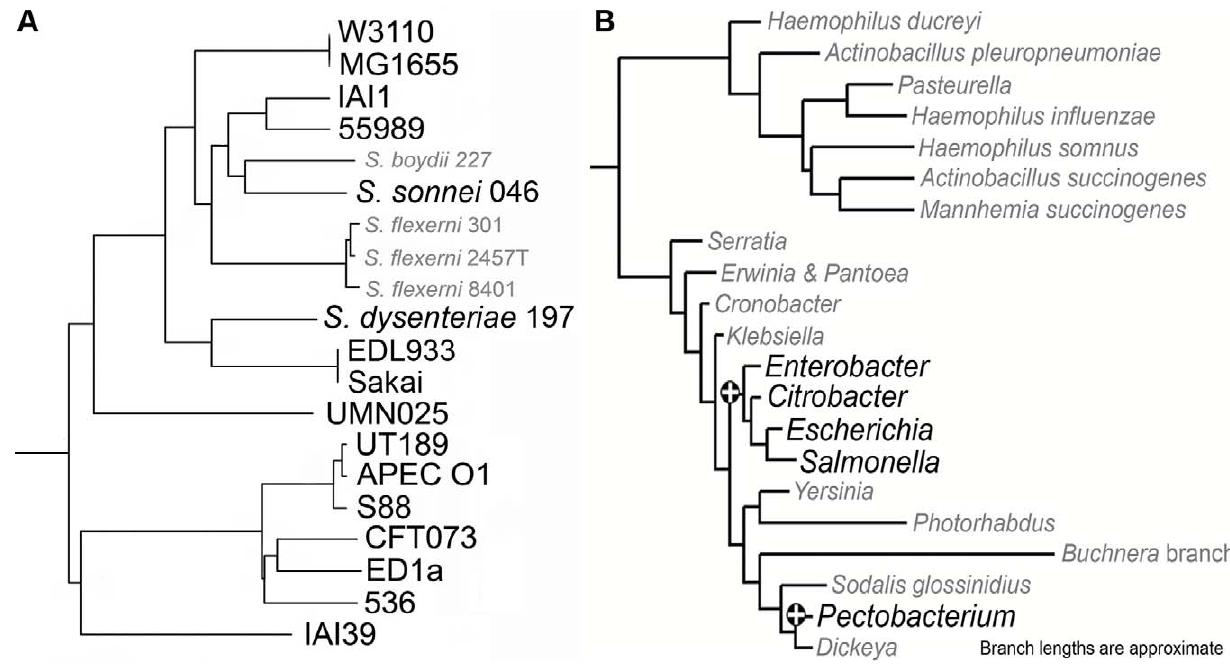
Figure 3. Lac operon LMNAST hits overlaid onto phylogenetic distributions of different scopes. The larger, bolded leaves represent species that contain lac operon homologs, whereas the grayed italicized leaves were completely bereft. A. An E. coli specific phylogenetic tree as adapted from [4], wherein all genes from the core E. coli were used to construct a consensus tree. Among the species/strains represented here, lac system homologs were absent from certain Shigella . Additionally, BW2952, SE11, IAI1, HS, E243227A, CFT073, K-12 DH10B, and 11 of 18 O:H serotyped strains contained truncated systems. Uniquely, CFT073 retains lacA , while missing lacI in an otherwise preserved lac system structure. B. The phylogenetic dispersion of the lac system is mostly limited to Escherichia and proximal species, as seen in the 16s based tree adapted from [5]. Bolded leaves indicate the presence of the lac system in at least one strain.